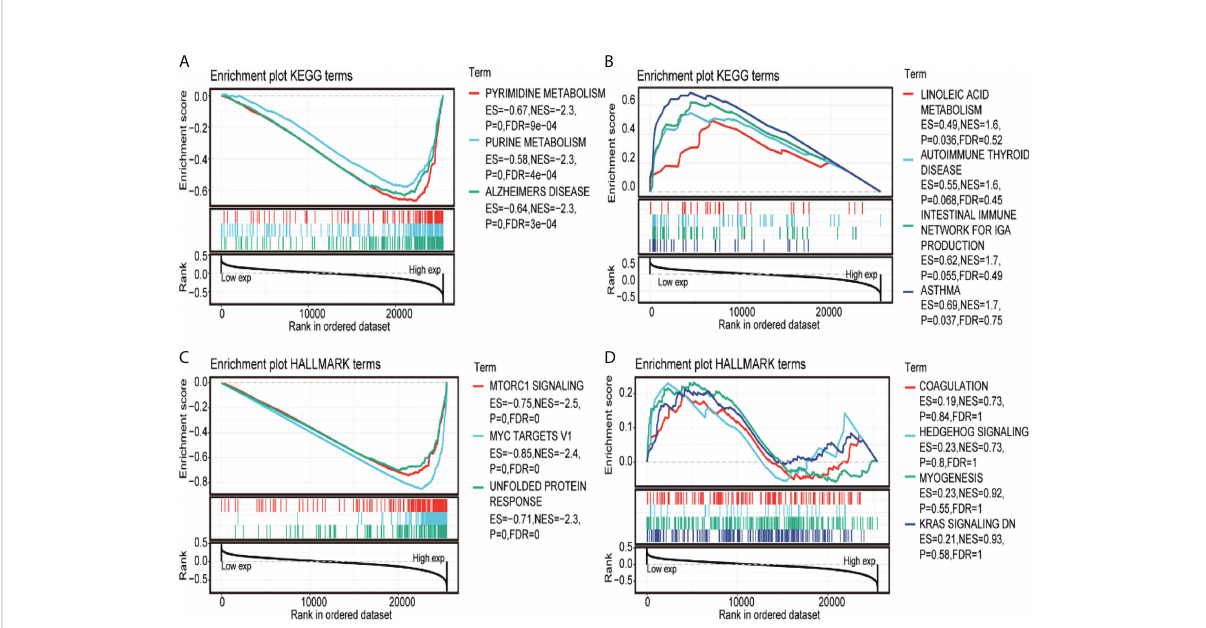
FIGURE 7 Gene set enrichment analysis (GSEA). (A, B) Kyoto Encyclopedia of Genes and Genomes annotation of CCT2 with GSEA. (C, D) HALLMARK annotation of CCT2 with GSEA.